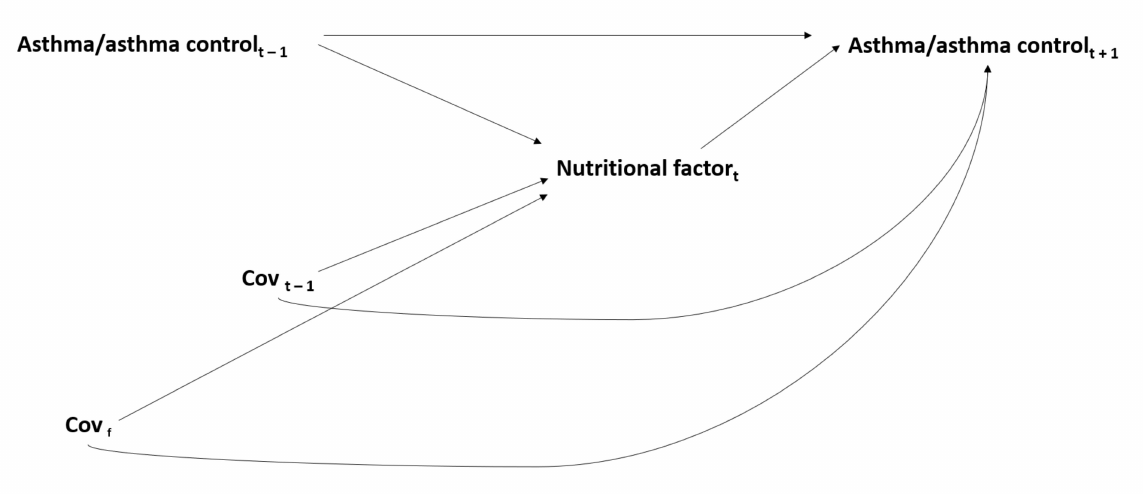
Figure 2. Issue of time-dependent confounding* in the interrelations between nutritional factors and asthma/asthma control. Cov f : time-fixed covariates; Cov t − 1 : time-dependent covariates at time t − 1; * For simplicity, the interrelations between each nutritional factor are not represented in this figure (see Figure